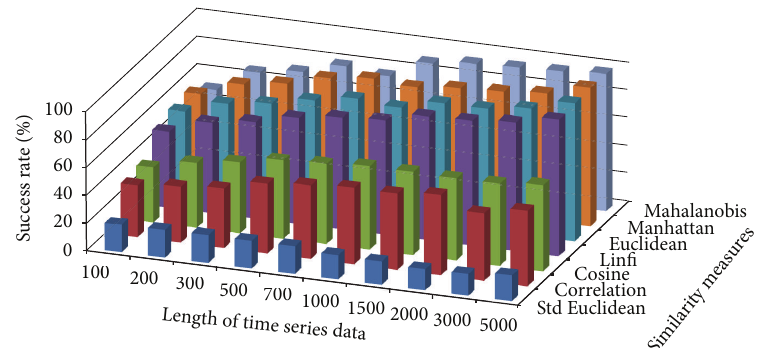
Figure 16: Average success rate of pattern recognition using DWT-based feature extraction in first scenario.